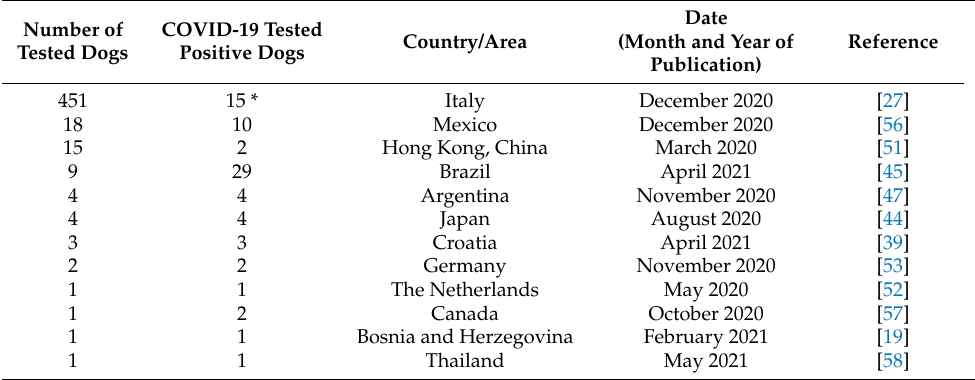
Table 2. Summarized reports of COVID-19 infections in dogs kept as pets (from the highest number of tested cats in particular study to the lowest one)